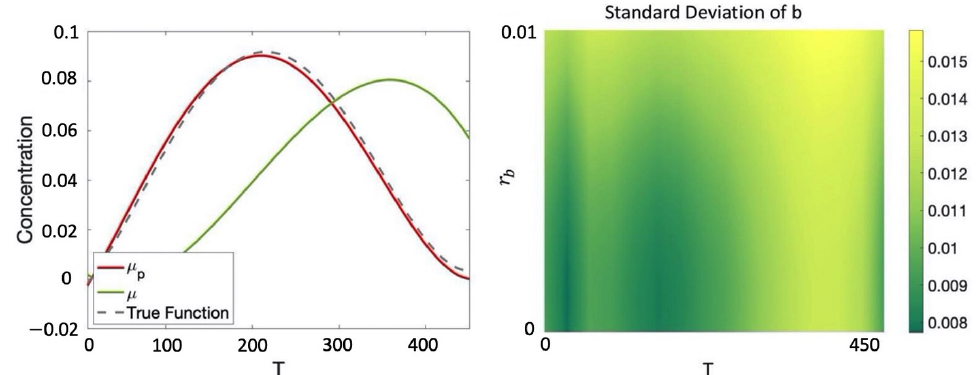
Figure 3. Mean and variance of species b for the CRN reported in Example 1 for r = [ 0.1, r b ,0.001,1,20 ] and u = [ T ] . ( Left: ) Evolution of µ (prior mean of species b given by Equation (1)), µ p (posterior mean of species b given by Equation (3)), and the true dynamics of species b , assumed to be a deterministic function for this example, for r b = 0.001 (initialization variable relative to species b ). It is possible to observe how, with just a few data points, the posterior mean reflects correctly the true dynamics. ( Right: ) Standard deviation of b after training (square root of solution of Equation (4)) as a function of r b and T . The variance is higher for combinations of T and r b where no training data are